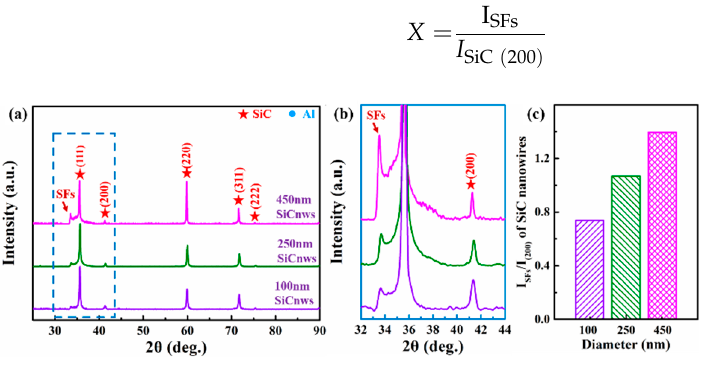
Figure 5. The XRD patterns of the raw SiCnws. ( a ) Overall patterns and the high magnification of the ( b ) 32°–44° of the SiCnws, ( c ) The SFs/(200) peak value ratio of the